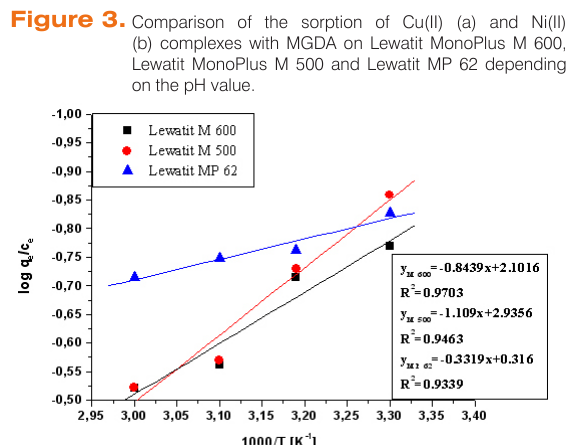
Figure 3. Comparison of the sorption of Cu(II) (a) and Ni(II) (b) complexes with MGDA on Lewatit MonoPlus M 600, Lewatit MonoPlus M 500 and Lewatit MP 62 depending on the pH value.